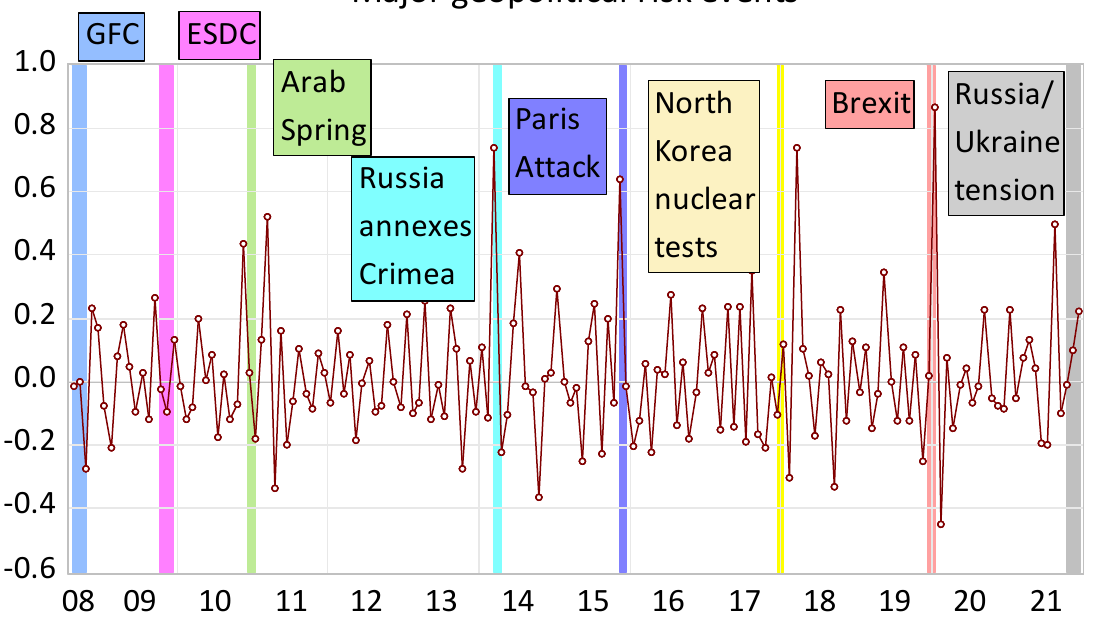
Figure 1. The time ‐ varying dynamics of the GPR index changes during the period of the study. Figure 1. The time-varying dynamics of the GPR index changes during the period of the